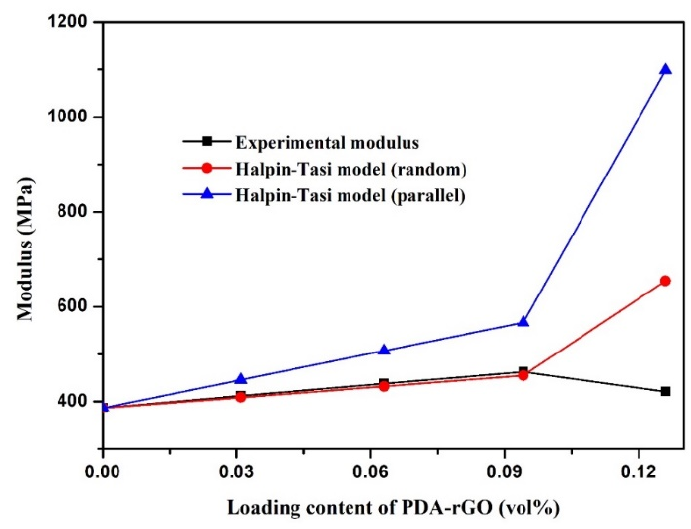
Figure 9. Experimental Young’s modulus data and theoretical Young’s modulus obtained by the Halpin–Tsai model for PDA-rGO/PA6 composite fibers.